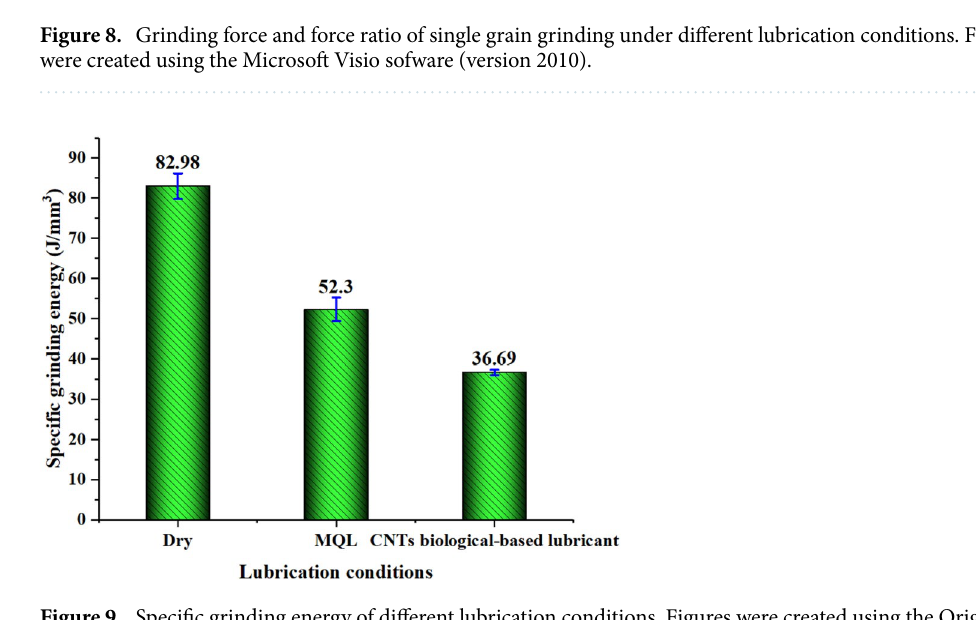
Figure 9. Specific grinding energy of different lubrication conditions. Figures were created using the Origin (version